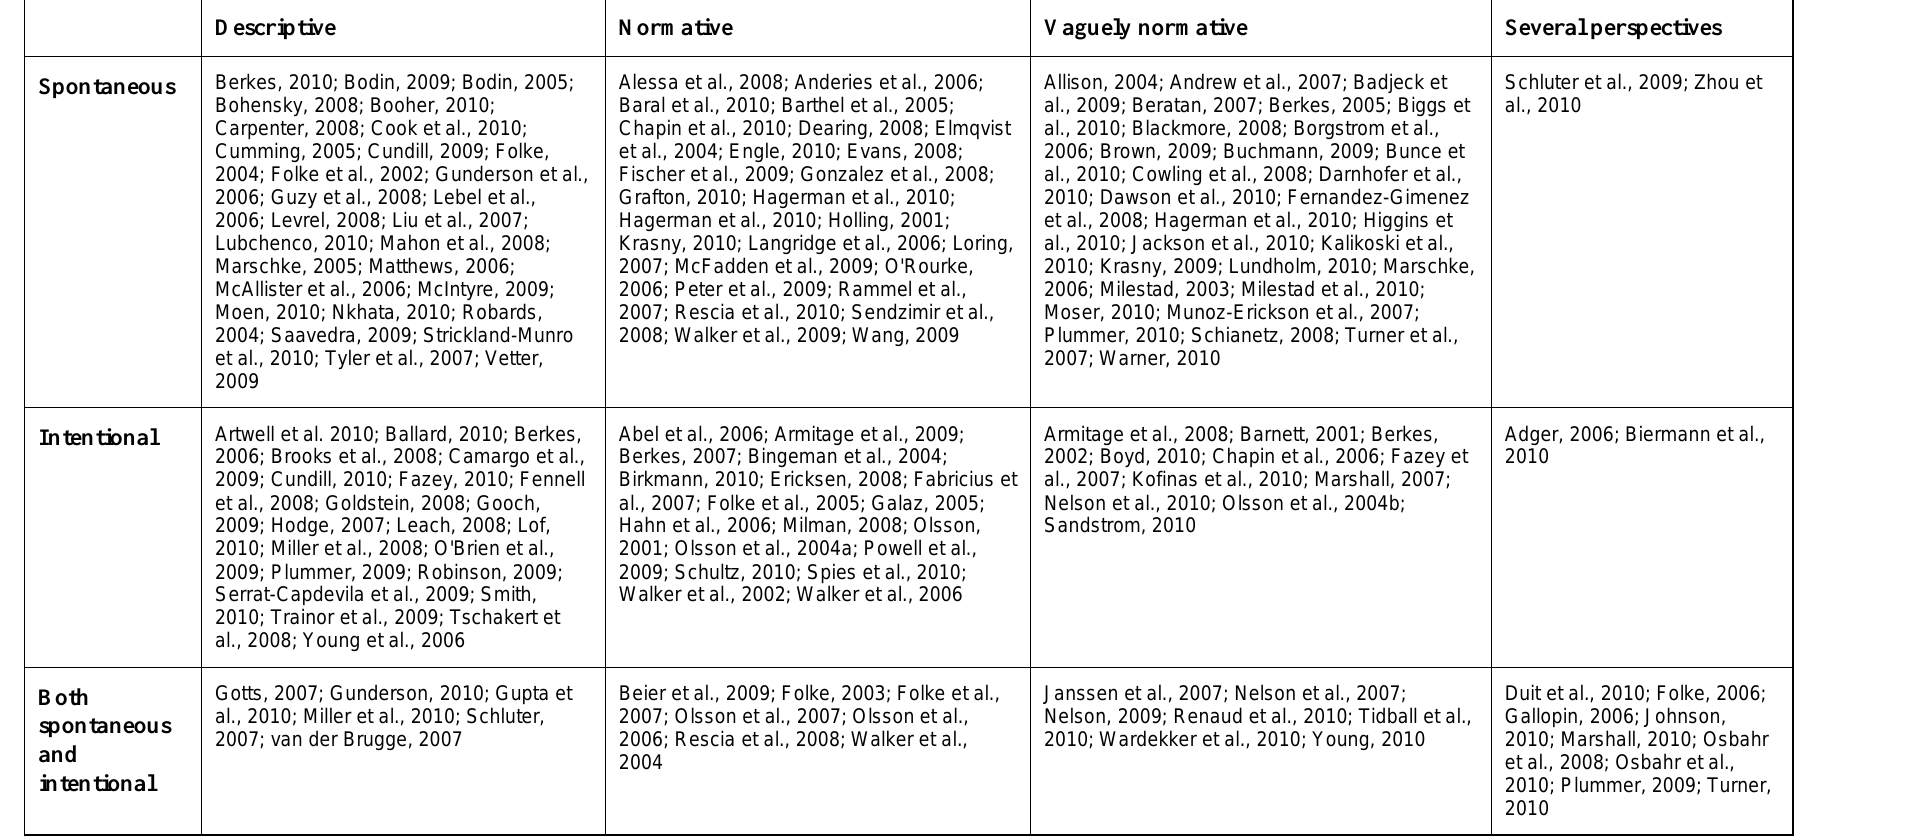
Table A2. Categorisation of all 183